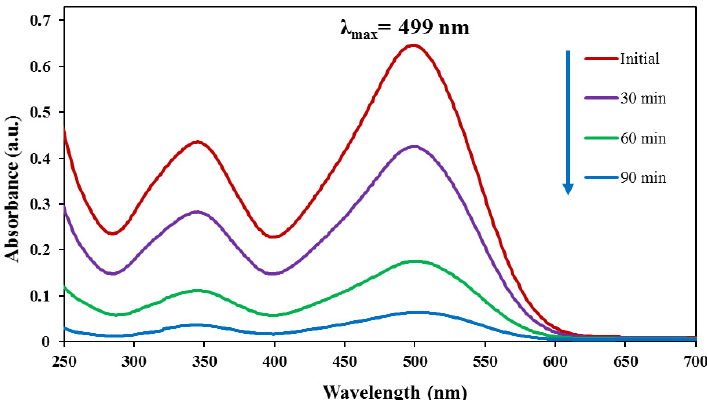
Fig. 9. Absorption spectra of CR solutions (20 mg/L) in the presence of 0.05 g of α -Fe 2 O 3 photocatalyst under visible light radiation.